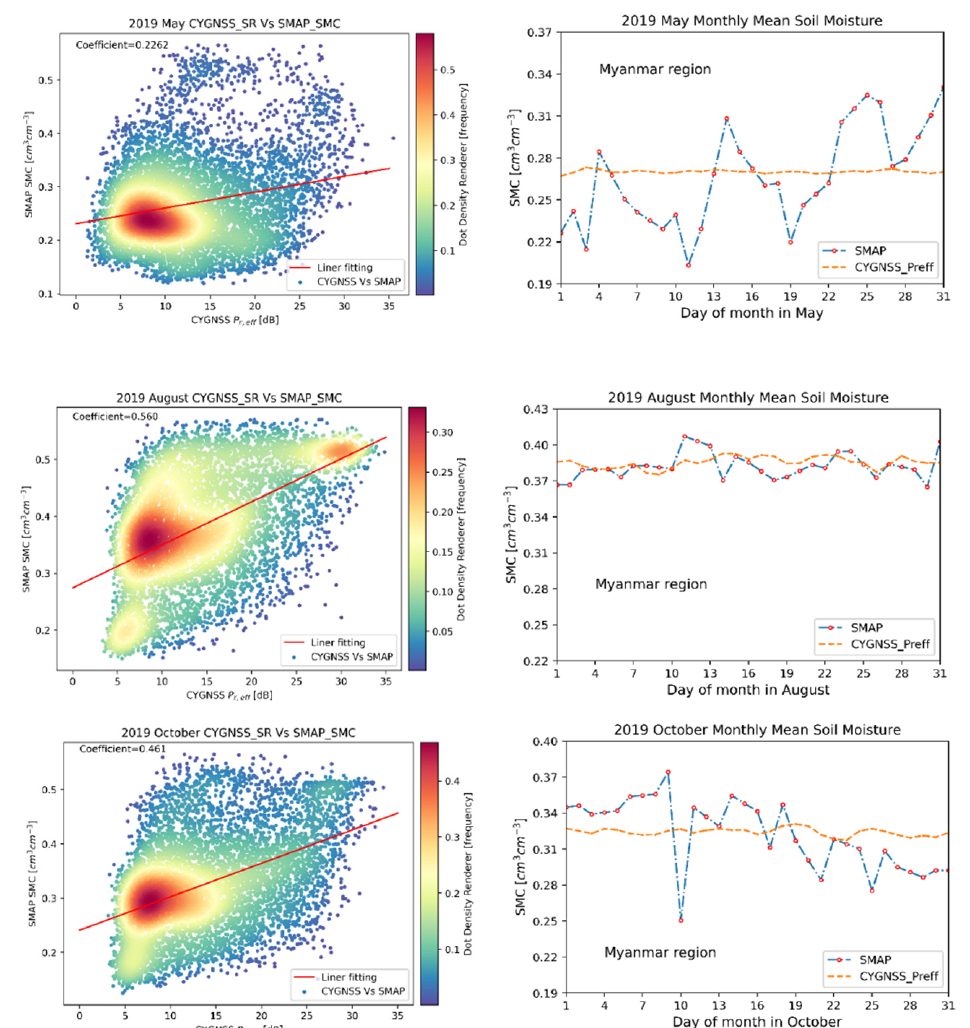
Figure 10. Surface Reflectivity P r,eff and SMAP correlation and monthly mean soil moisture in May, August, and October 2019. The correlation calculation was completed using EASE 2.0 gridded to a 9 km × 9 km scale for CYGNSS and SMAP for the regional SM analysis. The correlation result was very different during the seasonal changes of May and August 2019. This meant a strong correlation (r = 0.560) between surface reflectivity P r,eff and SMAP SM in May and August. Figure 11 shows daily mean soil moisture changes from May, August, and October 2019. As stated, earlier, the correlation coefficient value was higher in August, which meant daily soil moisture was significantly increased compared to other months. Myanmar had frequent meteorological depressions and tropical cyclones in the monsoon season until October. As a result, the surface area was more saturated, which influenced soil moisture